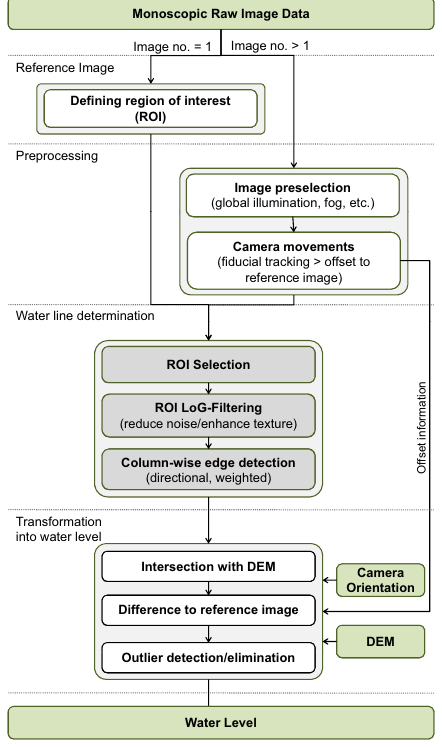
Figure 4. Schematic representation of the image analysis.